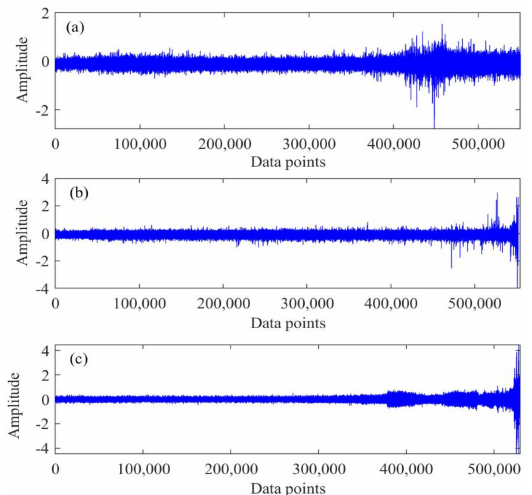
Figure 5. Exemplary diagram of bearing vibration data: ( a ) rolling fault; ( b ) inner fault; ( c ) outer